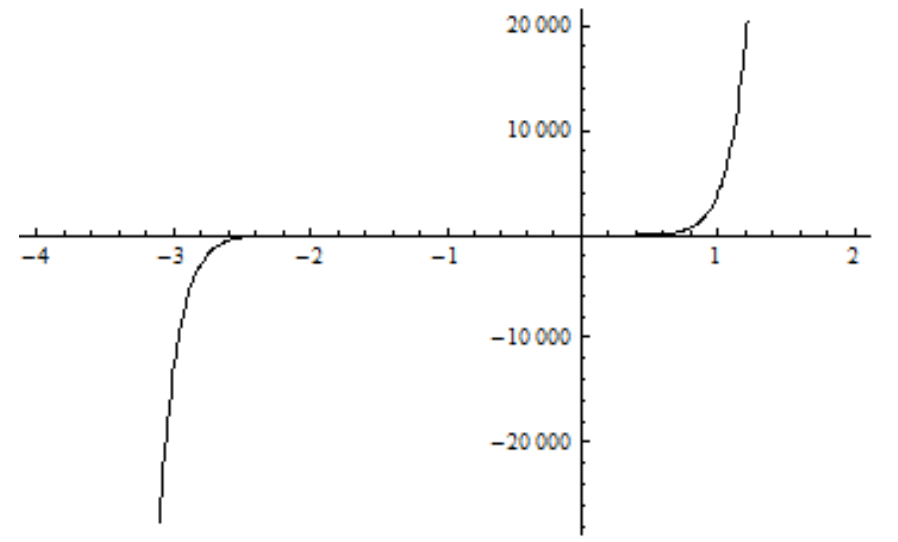
Figure 3. The h -curve of ) 0 , 1 ( u of the equation (23) obtained by the sixteen-terms approximation tt solution of the Homotopy analysis method